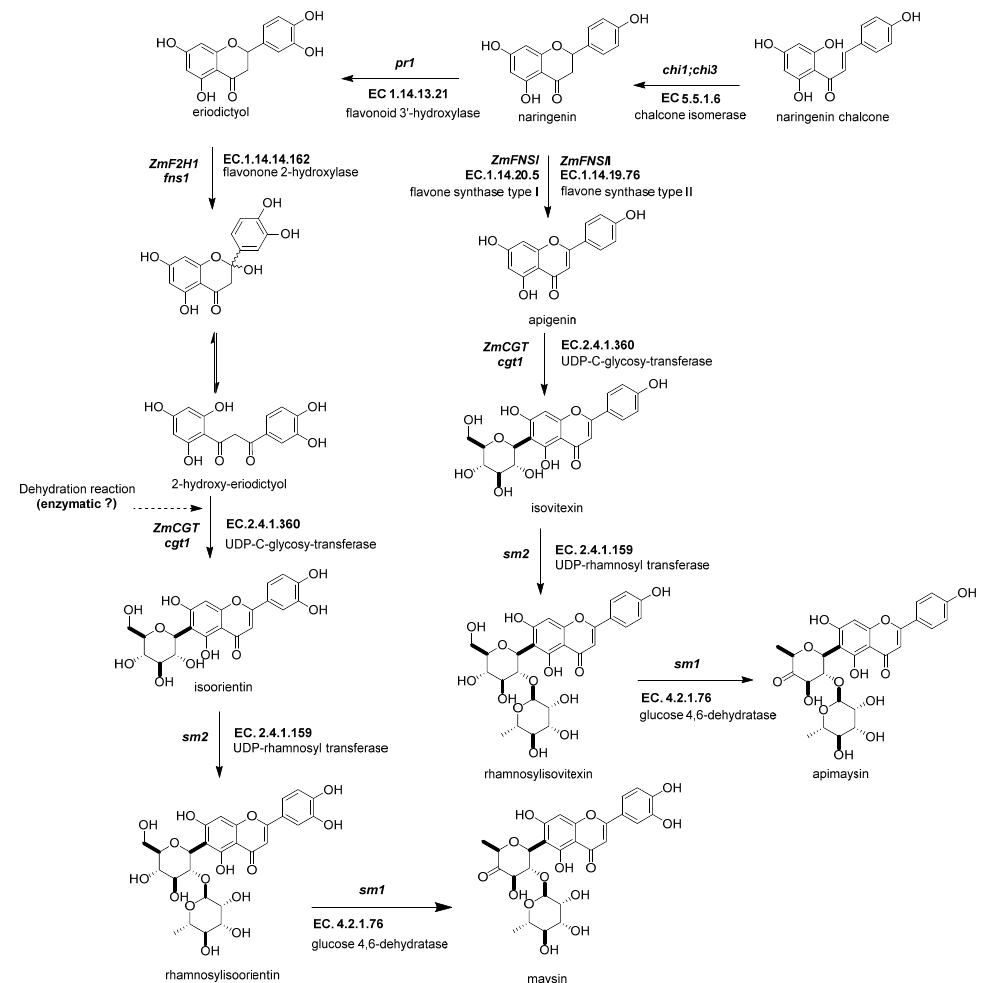
Figure 5. Biosynthetic genes of flavone C-glycosides. The flavanones naringenin and eriodictyol are the initial substrates for the other flavonoid subgroups. There are two possible ways to generate C-glycosyl flavones, indirectly or directly, from any flavanone. The indirect pathway begins through flavanone-2-hydroxylase ( ZmF2H , fnsii1 , EC 1.14.14.162) opening the C-ring, producing a 3-oxo-dihydrochalcone. Then, UDP C-glycosyl transferase ( ZmCGT , cgt1 , EC 2.4.1.360) generates a glycosidic bond in the A-ring. Then, there is a dehydration reaction (spontaneous or enzymatic) that produces the C6-flavone glycoside. The direct pathway firstly involves flavone synthase I ( ZmFNSII-2 , fnsii2, EC 1.14.20.5) and flavone synthase II ( ZmFNSII-1 , fnsi2 , EC 1.14.19.76) producing the same reaction by the addition of a double bond between C2 and C3 in the flavanone. Then, a flavone functions as a substrate for the UDP C-glycosyl transferase ( ZmCGT , cgt1 , EC 2.4.1.360). The enzymatic action of UDP-rhamnosyl transferase ( ZmCGT , sm2 , EC 2.4.1.159) and glucose 4,6 dehydratase ( sm1